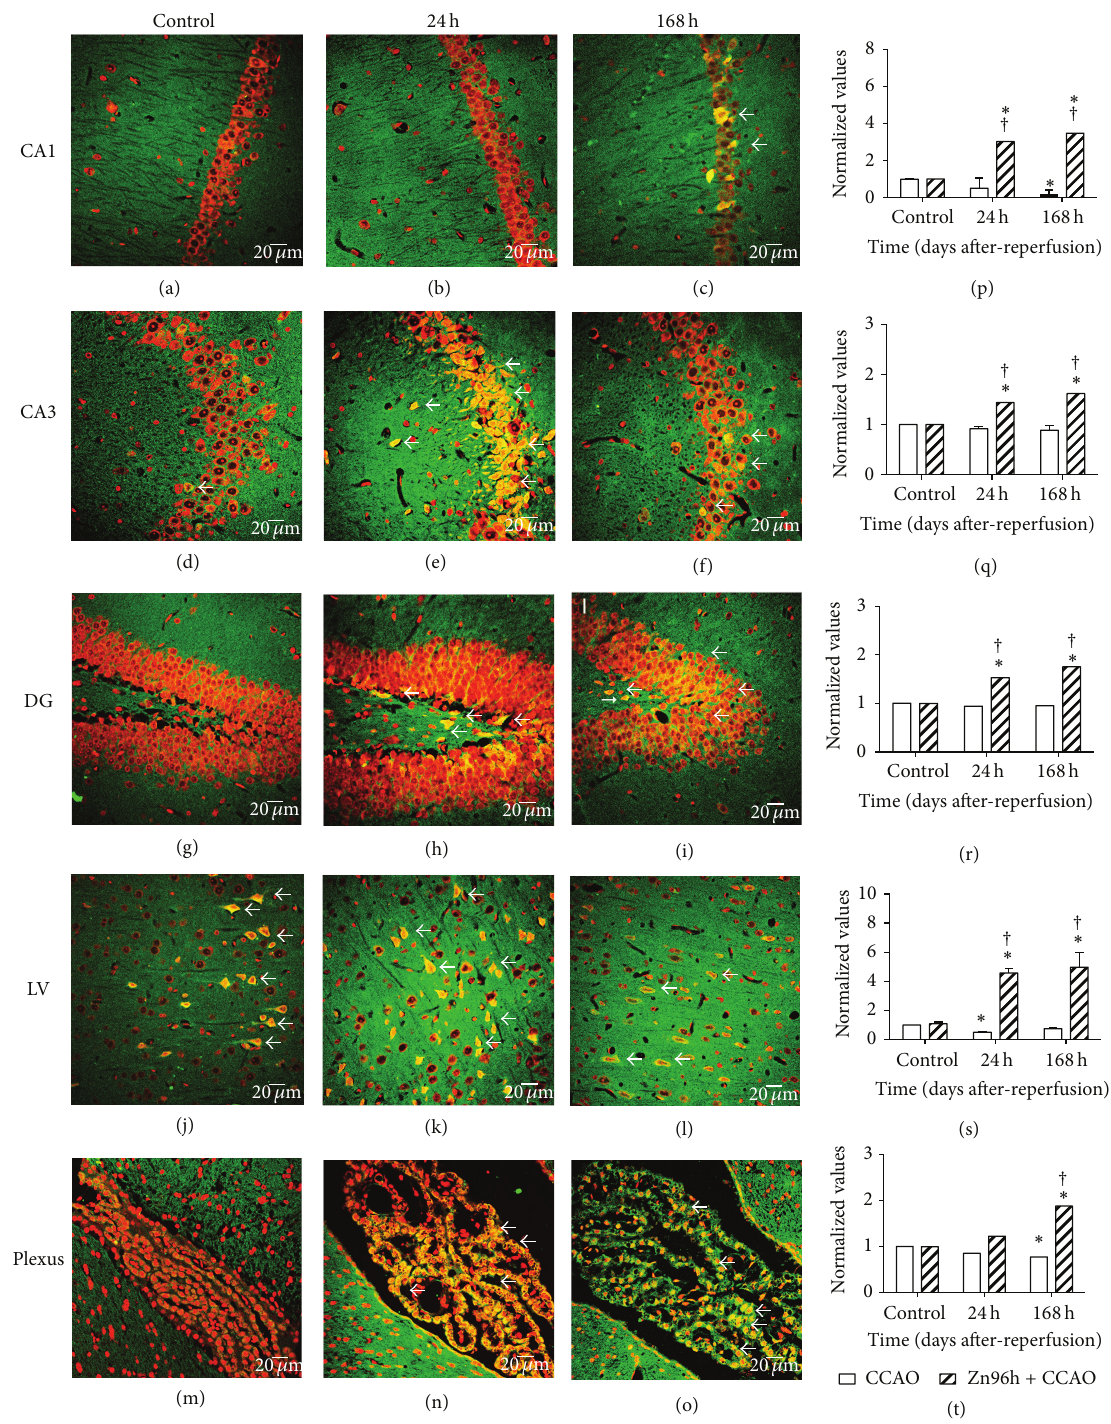
Figure 4: Effect of the subacute administration of zinc on CCR2 immunoreactivity after CCAO. Representative micrographs of CCR2 immunofluorescence ((a) to (o)) using a rabbit antibody against CCR2 and a goat antibody anti-rabbit IgG conjugated with fluorescein isothiocyanate (green color). The cerebral region was identified with propidium iodide (red color) counterstaining. Graphs ((p), (q), (r), (s), and (t)) show the normalized values of CCR2-IR with respect to control IR for CCAO (Figures 3(a) to 3(o)) and subacute administration of zinc ((a) to (o)). The IR was measured using ImageJ 1.45 of the National Institute of Health. CA, Cornu Ammonis, and DG, dentate gyrus, of the hippocampus. LV, layer V of the cerebral cortex. Plexus, choroid plexus. Values are expressed as the mean ± SEM from 3 rats for each experimental condition. ∗ , significant when compared with the control group; ANOVA test and post hoc Dunnett’s test. † , significant when compared between groups; unpaired Student’s 𝑡 -test. 𝑃 < 0.05